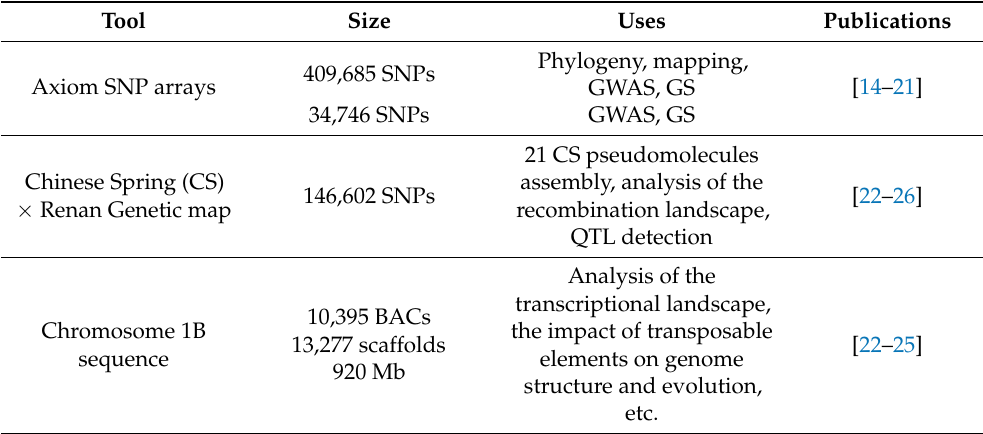
Table 1. Summary of genomics tools developed within the BREEDWHEAT project. Tool Size